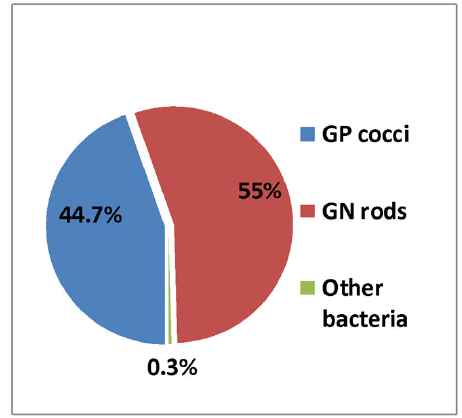
Figure A1. Annual evolution of the bacterial strain isolates and number of the biological samples in Galati, Romania (2019–2021).